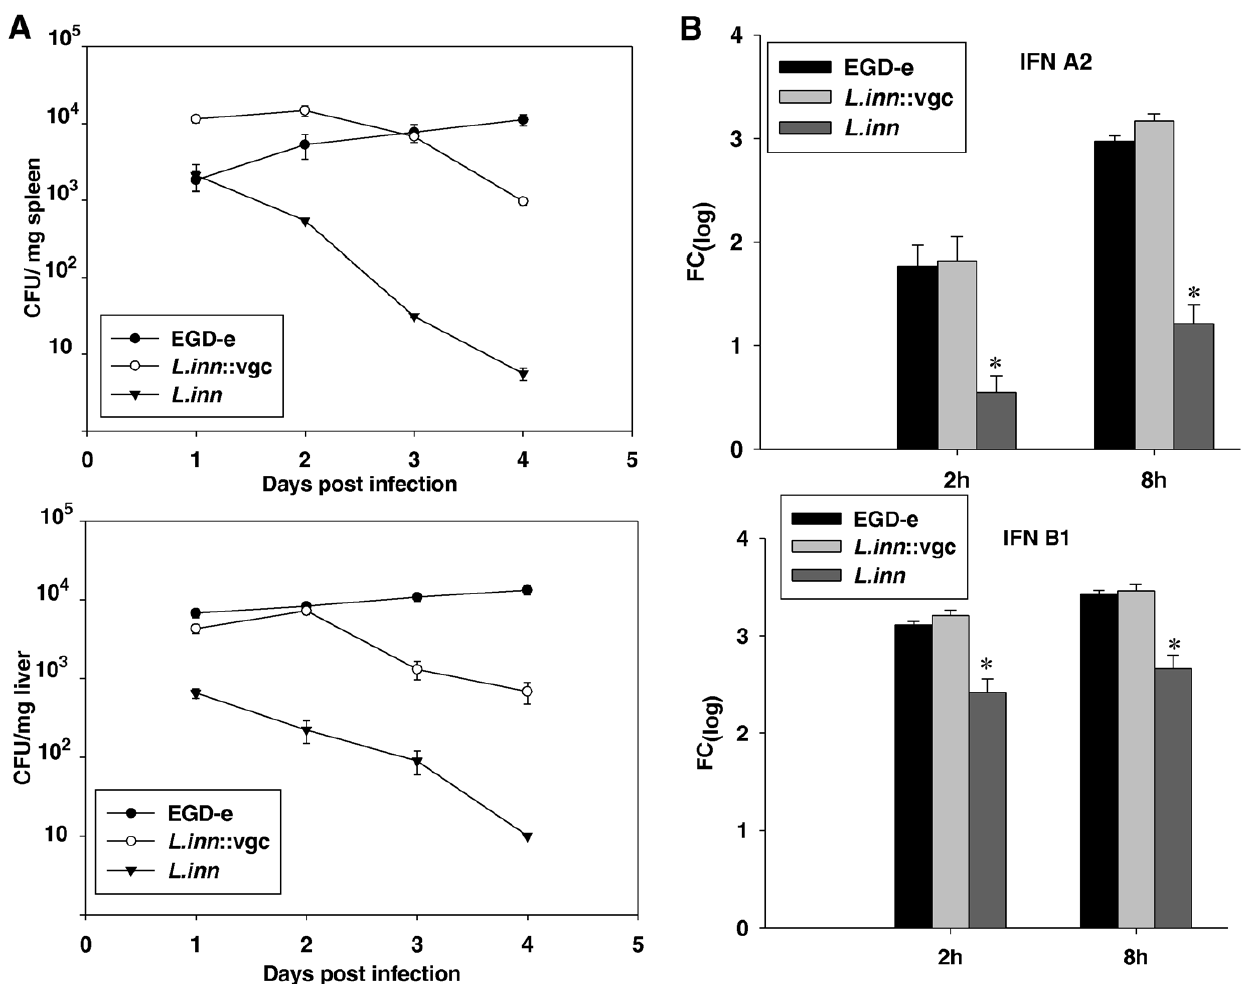
Figure 1. Bacterial load and IFN expression during the course of primary infection. A. Course of primary infection in mice with the wild type Lm (EGD-e) and the recombinant L. inn ::vgc strain. Mice were infected i.v. with 10 3 cfu Lm , 10 7 cfu L.inn , or 10 7 cfu L.inn::vgc strains. At different time intervals after the infection, mice were sacrificed and the number of viable bacteria in the organs was enumerated. B. Quantitative measurement of IFN a 2 and IFNb1 expression in bone marrow-derived macrophages using RT-PCR at 2 h and 8 h following infection with Lm , L.inn , or the L.inn :: vgc strains. *P , 0.05 ( L.inn vs. Lm and L.inn::vgc strains).